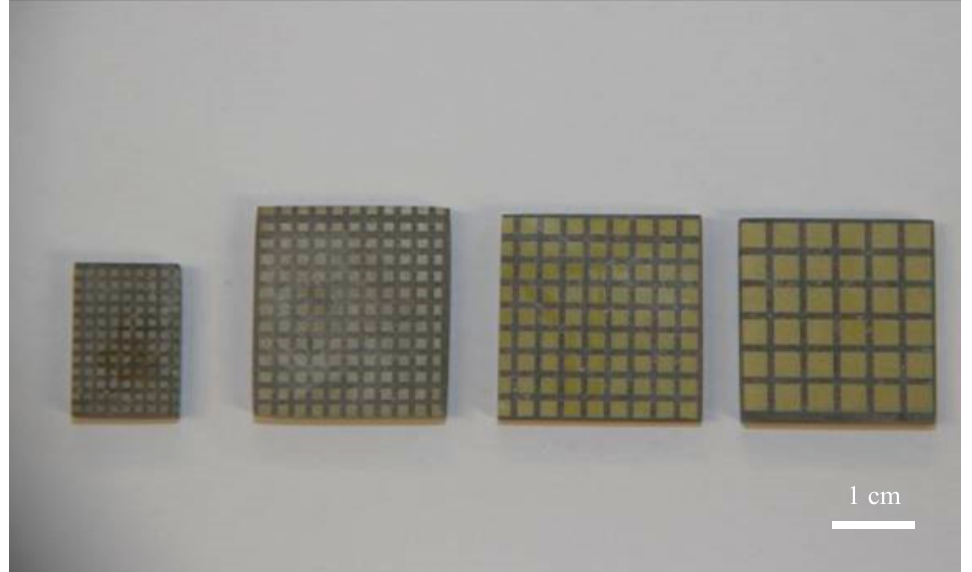
Figure 5. Specimens of 1-3 type cement based PZT composite.